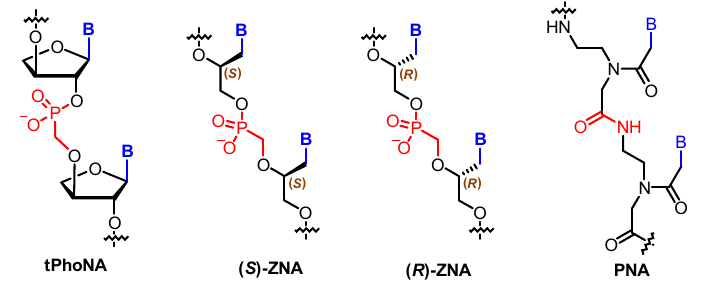
Figure 7. Structures of tPhoNA, ZNA, and PNA.